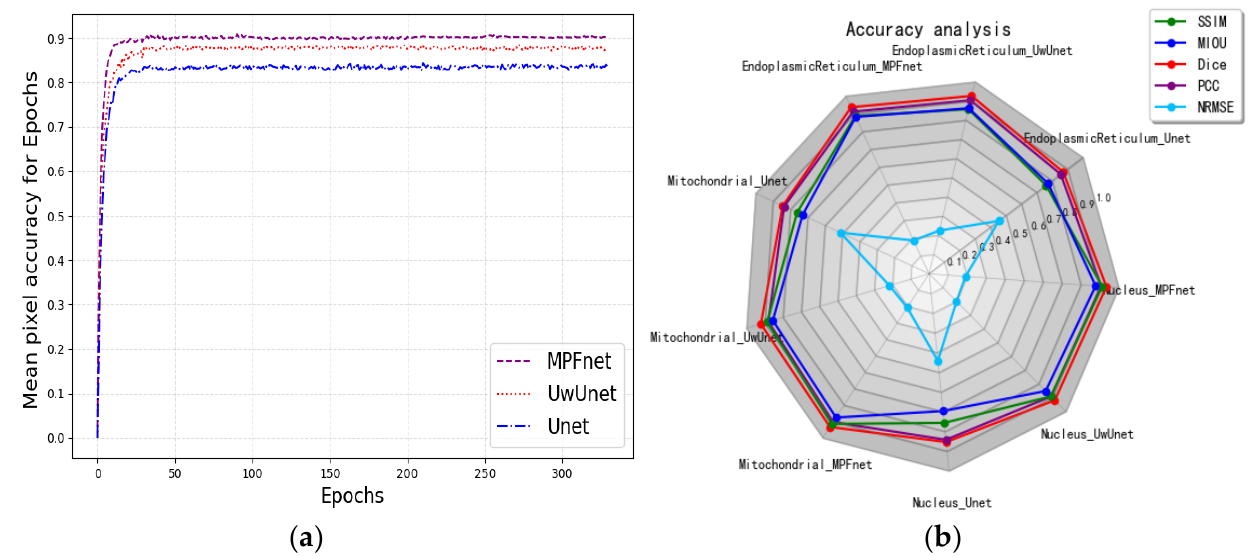
Figure 4. ( a ) Mean pixel accuracy comparison among different methods. Purple dash line, red dot line, and blue dash-dot line represent MPFnet, UwUnet, and Unet models, respectively. ( b ) Radar chart for quantitative comparisons of different predictive models.